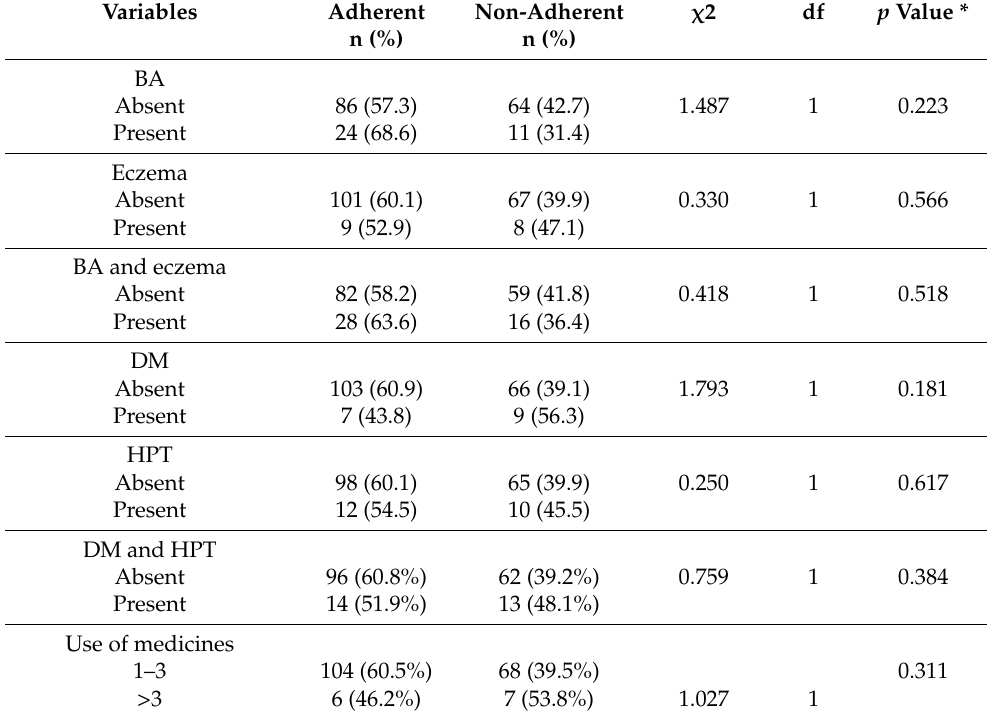
Table 3. Comorbid medical conditions and use of